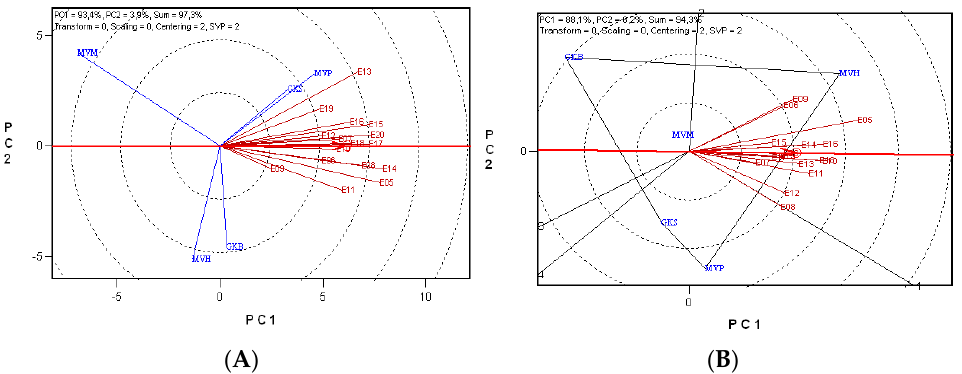
Figure 1. Polygon view of the GGE biplots (‘which-won-where’ model) for five durum wheat cultivars based on the gluten index ( A ), or on the Minolta b* value ( B ) over 16 years. Environment-centred (Centering = 2) GGE biplot analysis based on non-scaled data (Scaling = 0) with environment-metric (SVP = 2) plotting. E05–E20: years 2005–2020; ‘GKB’, ‘GKS’, ‘MVM’, ‘MVP’, ‘MVH’: genotypes; PC1, PC2: principal component variables; environment vectors are plotted with thin and the average environment axis (AEA) with a thick red line; O: year mean. The ranking biplot method was used to evaluate the genotypes on the basis of gluten index and Minolta b* value means and their stability across environments (Figure 2). The variability (poorer stability) in either direction. With regard to gluten index, in all 16 years ‘MVP’ had the highest mean gluten index, followed by ‘GKS’, while ‘MVM’ had the